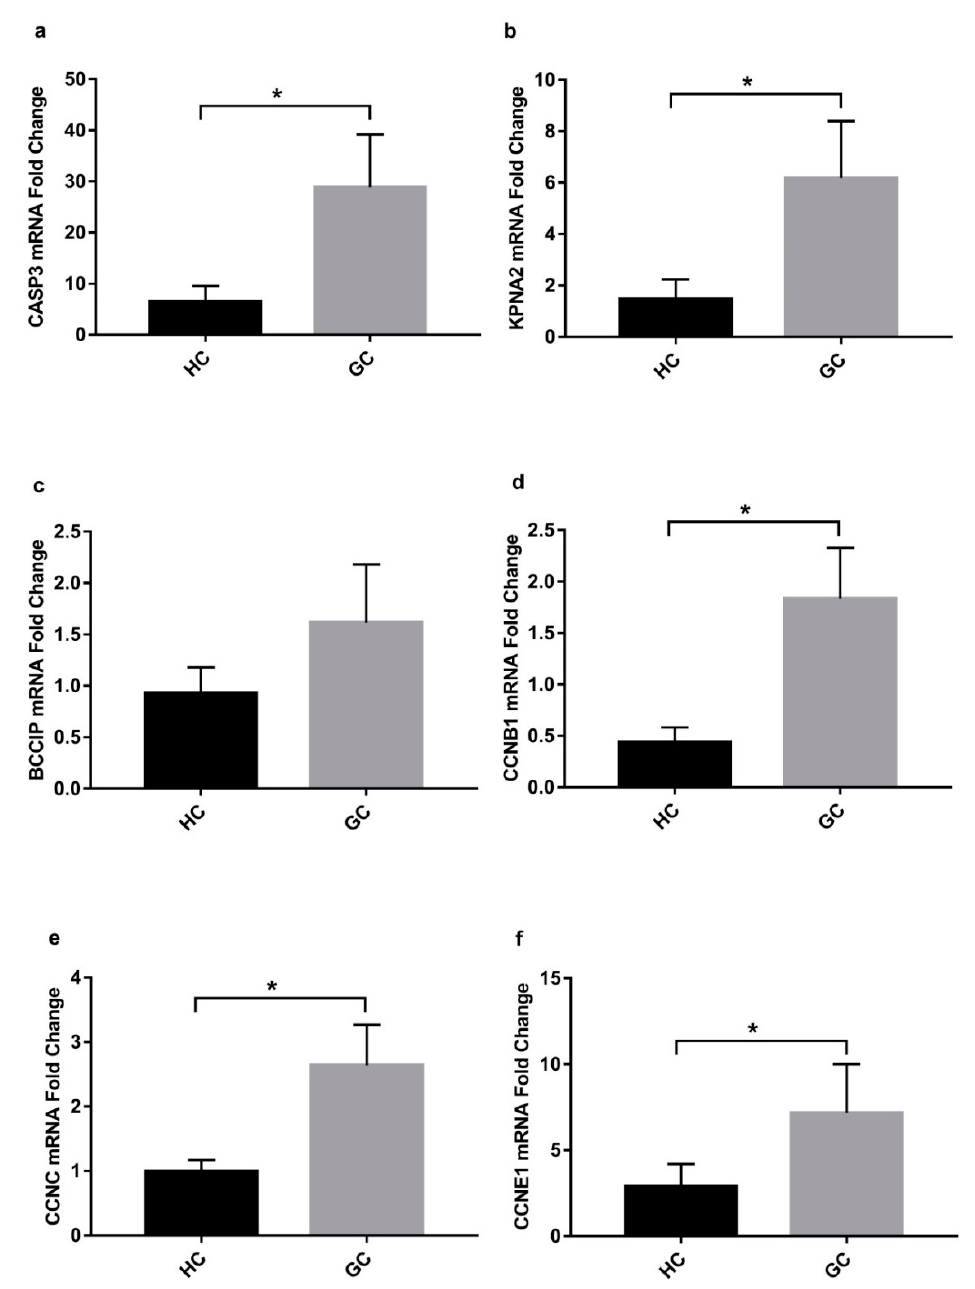
Figure 7. Real-time analysis of cell cycle genes performed on biopsies of gastric cancer tissue shows that the genes differentially modulated in cell lines are overexpressed in gastric cancer in comparison to healthy controls ( a – f ). Data are shown as mRNA fold change ± SD. HC: healthy control; GC: gastric cancer biopsies. * p < 0.05.